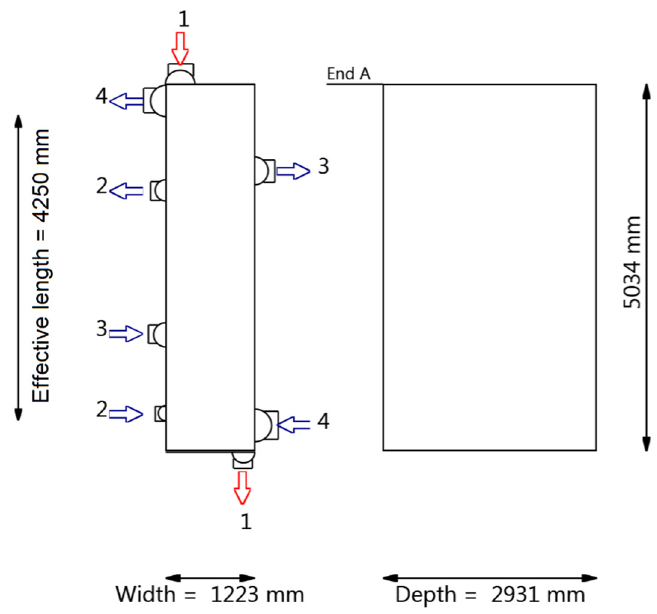
Figure 7. Heat exchanger HX2a (generated in Aspen MULE).